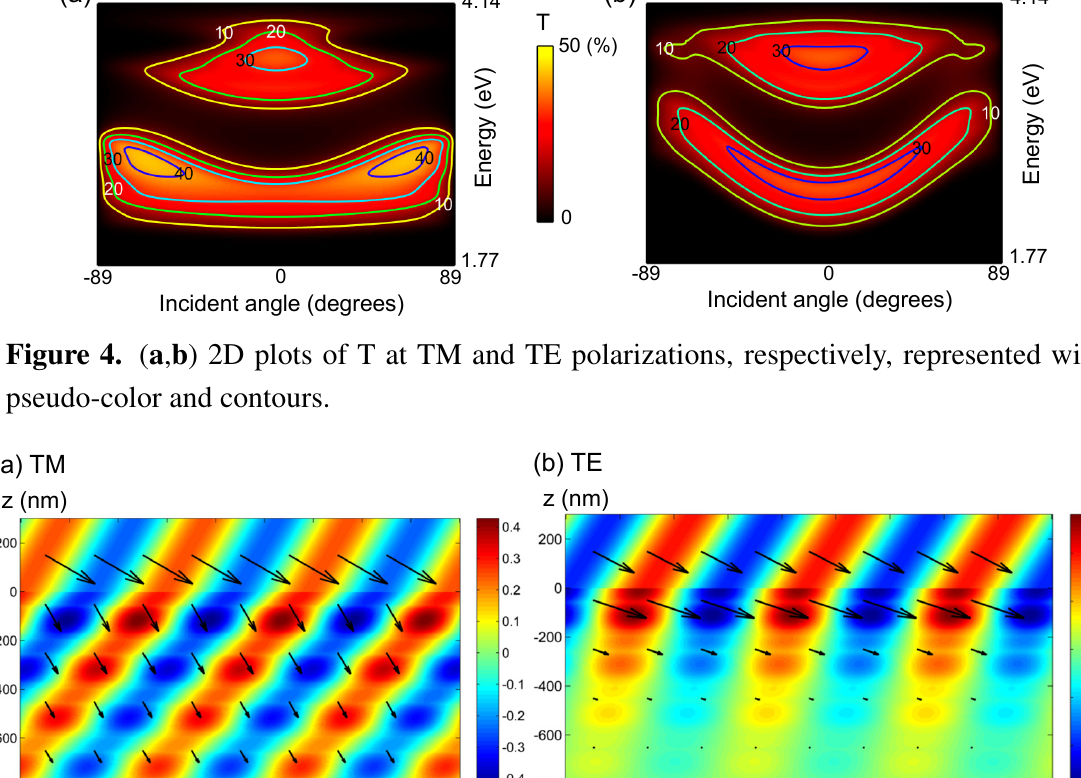
and (b) E components. The incident y y